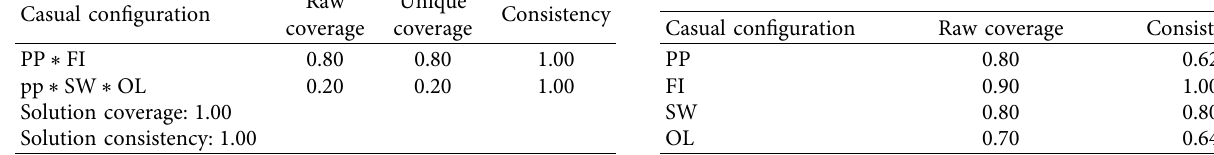
(b) Cross-tab showing “pp ∗ SW ∗ OL” as a sufficient condition for credit default